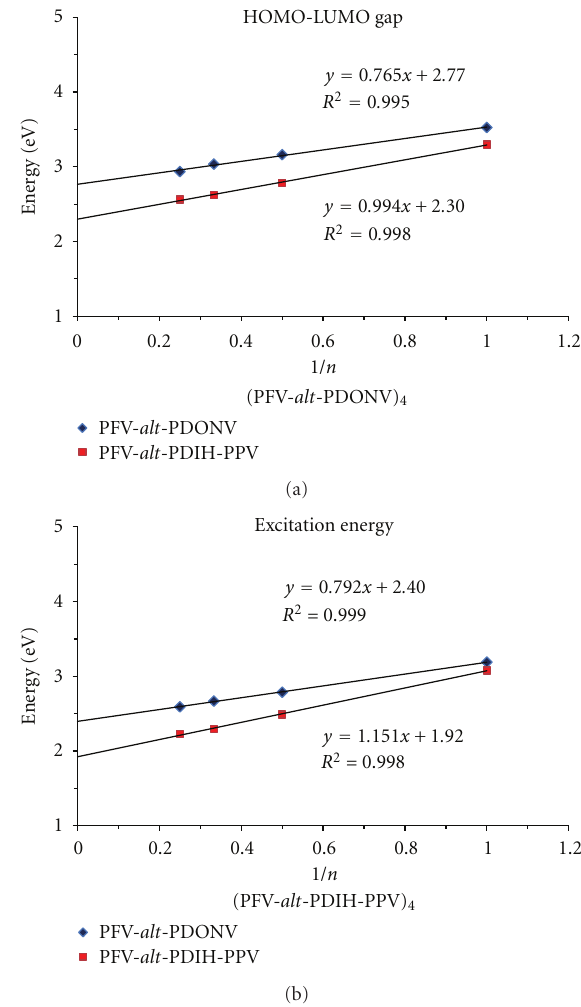
Figure 4: The HOMO-LUMO gaps ( Δ H − L ) by B3LYP and the lowest excitation energies ( E g ) by TDDFT as a function of reciprocal chain length n in oligomers of PFV- alt -PDONV and PFV- alt -